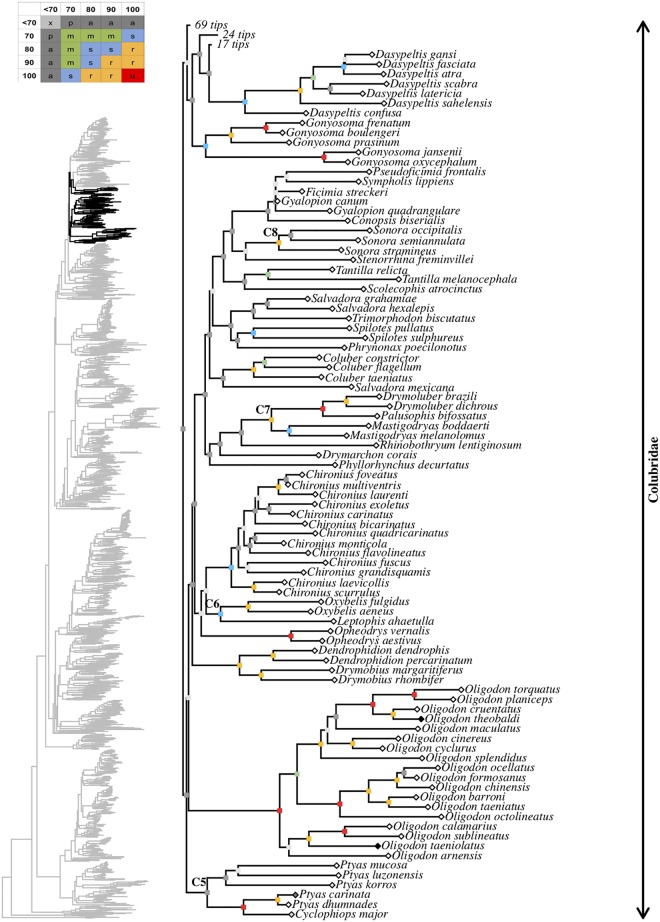
Maximum likelihood species-level phylogeny of Colubroides
(continued).Family Colubridae (continued).